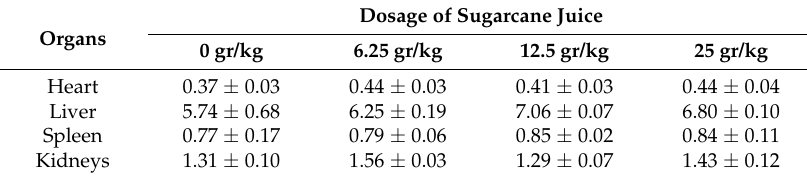
Table 3. Mice organ weight measurements for acute toxicity analysis.